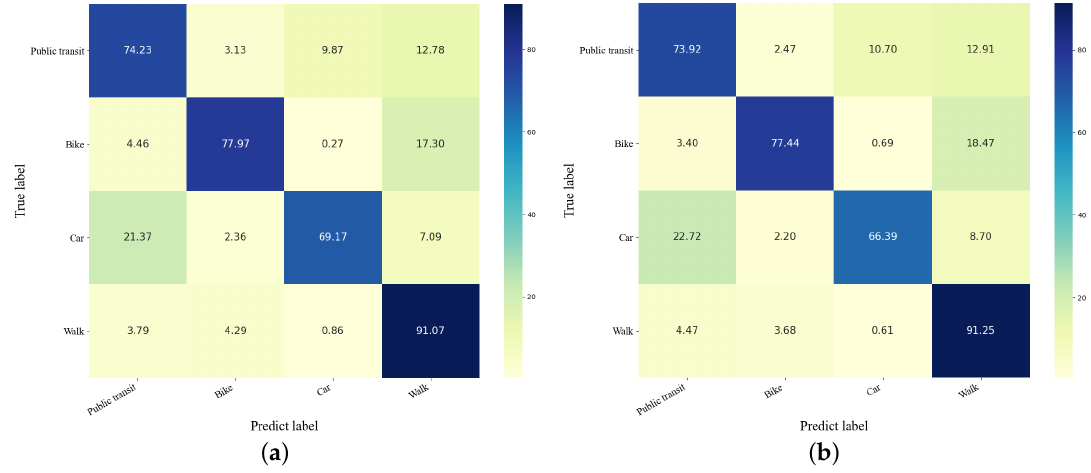
Figure 7. The Confusion matrix of the Geolife dataset. ( a ) Motion+GIS. ( b ) Motion.